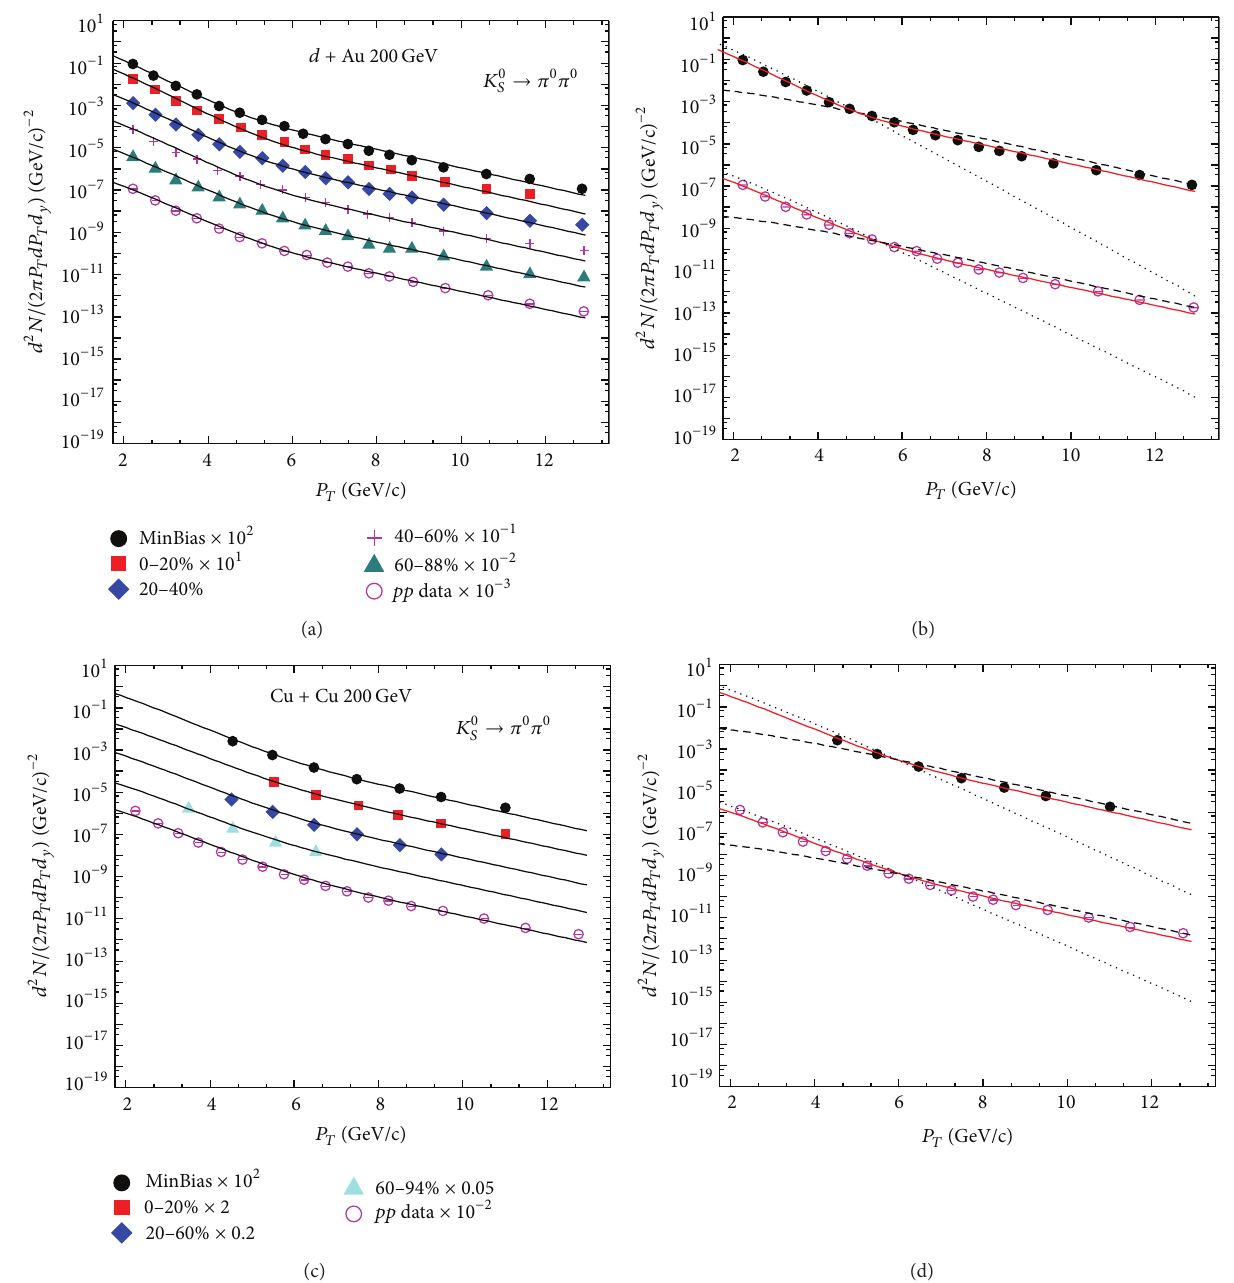
Figure 3: The same as Figure 1, but the solid lines are the results of (9). The dashed lines and the dotted lines denote the contributions of the first component and the second component,